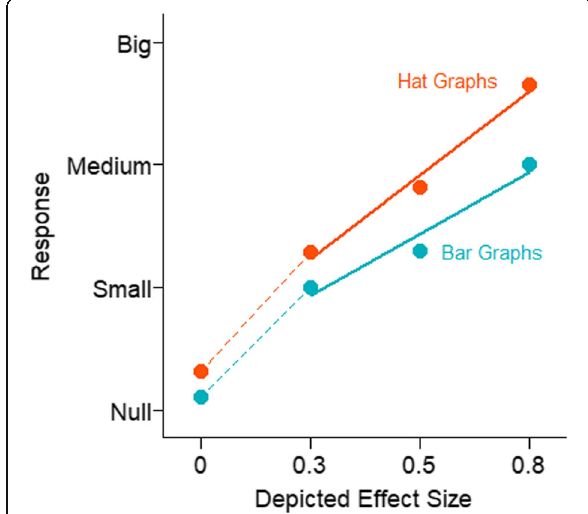
Fig. 12 Mean response is plotted as a function of depicted effect size in the stimuli and graph type for experiment 3. Solid lines represent the mixed linear model coefficients. Steeper lines are indicative of better sensitivity. The dashed lines connect the mean estimated magnitude of null effects and small effects. The data from the depicted null effects were not included in the analysis